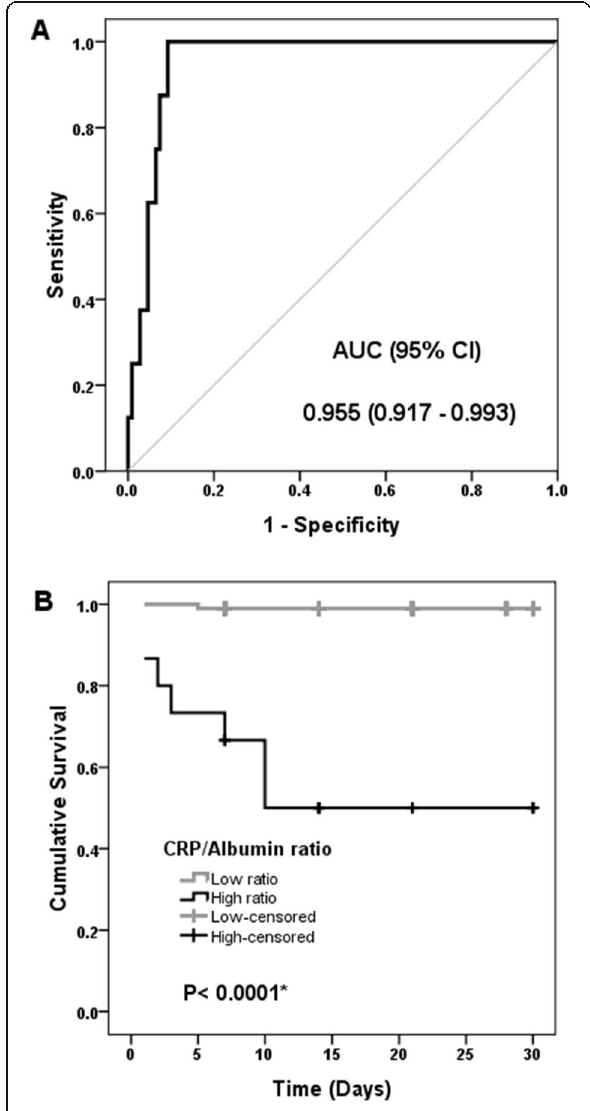
Fig. 3 a ROC curve of CRP/albumin ratio as a predictor of COVID-19 mortality. b Kaplan-Meier survival curve according to the CRP/ albumin ratio